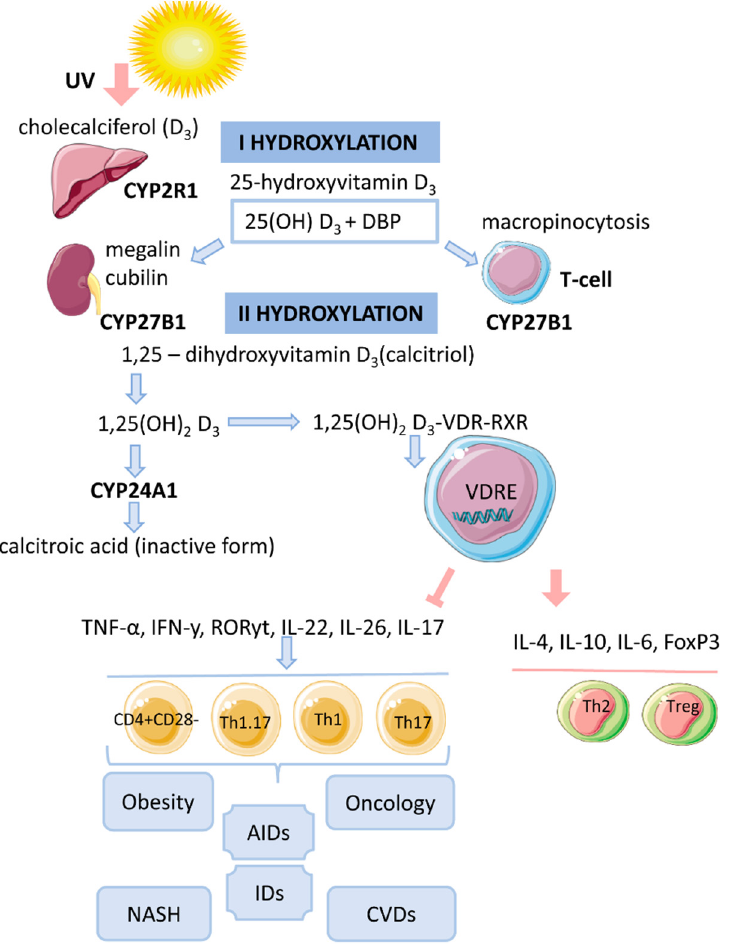
Figure 1. The mechanism of action of vitamin D on T cells in